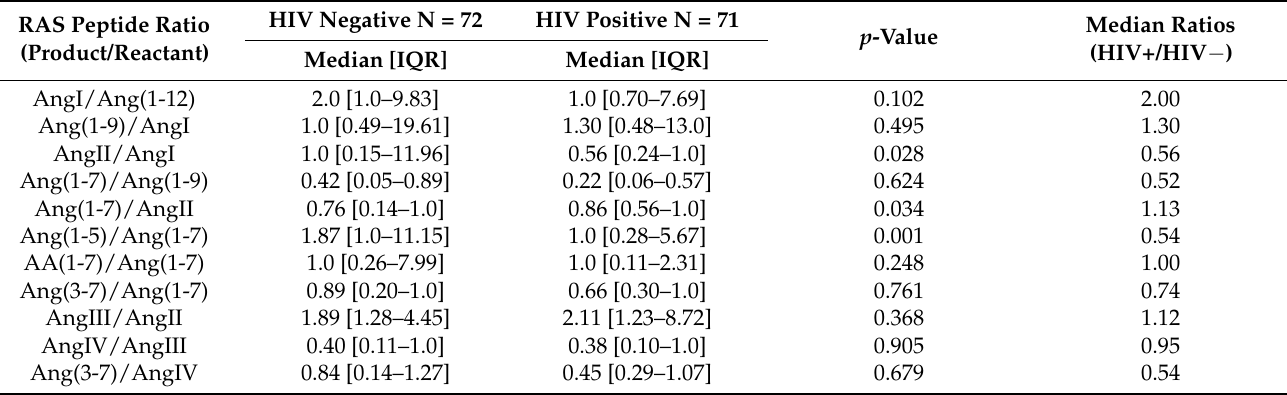
Table 3. Plasma RAS peptide ratios (product/reactant) at study